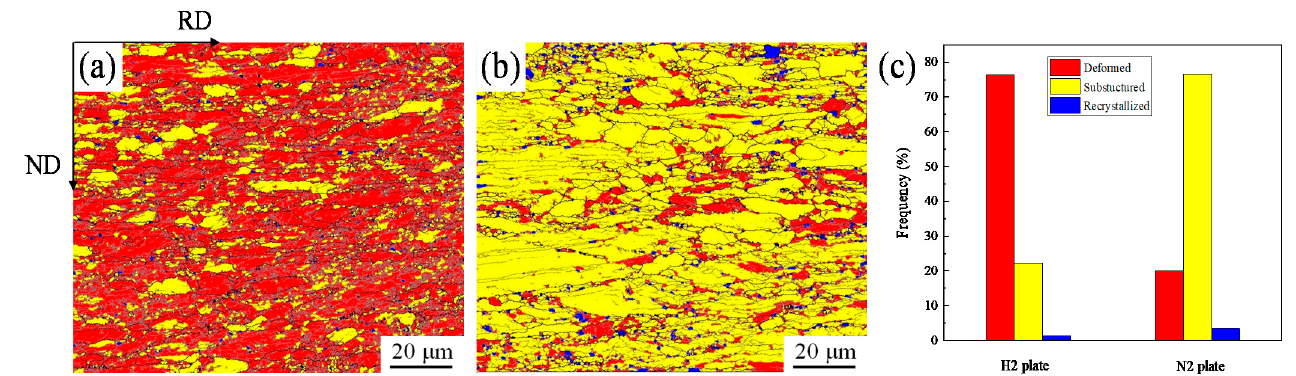
Figure 5. Recrystallized, substructured and deformed microstructures of the 1561 aluminum alloy with different states. ( a ) the H2 plate ( b ) the N2 plate ( c ) Statistical distribution histogram. Figure 6 shows the variation of grain size calculated by the EBSD maps, and it shows that the average grain size of the H1 plate is 18.95 µ m, while that of the H2 plate is 1.19 µ m, respectively. After annealing, the average grain size of the N1 plate is 28.34 µ m, while that of the N2 plate is 10.69 μ m. The smaller grain size of the N2 plate is partially because of the existence of more deformations, which exist due to the energy of refinement grains and hinder the movement of grain boundaries. Additionally, it is noted from Figure 3e–f that there are many fiber textures in the ingot core of the H2 plate. Orientation imaging shows that there are many small-angle grain boundaries after deformation. They are all potential recrystallization nucleation sites. The grain size distribution is uneven, and in- dividual grains grow abnormally.